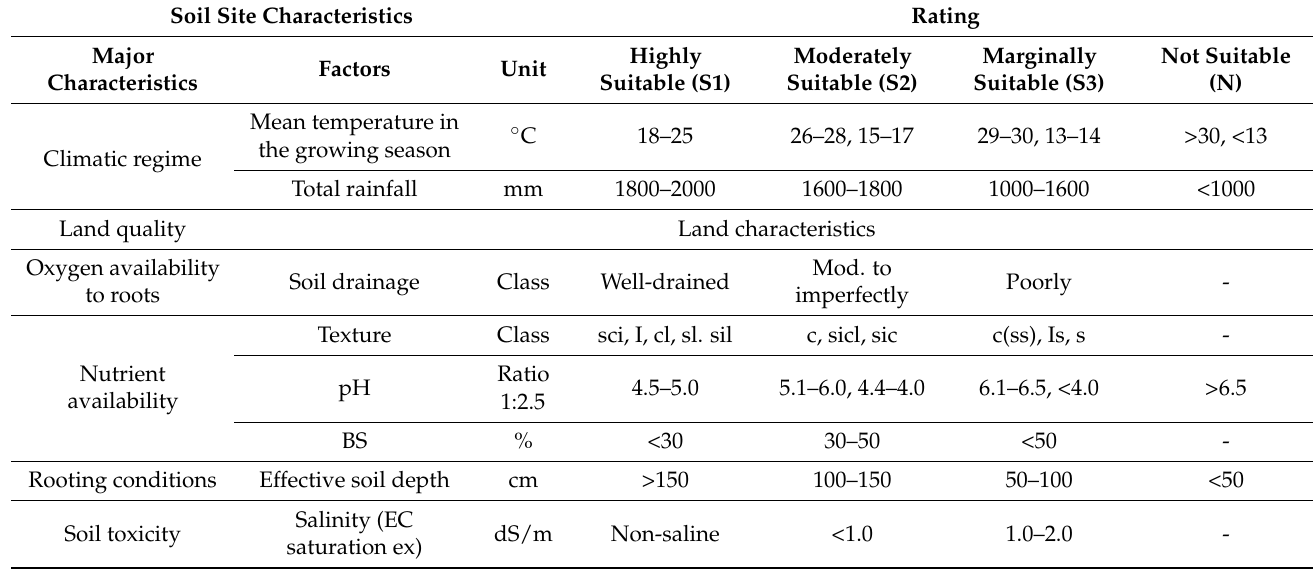
Figure 2. Suitability thematic layers for tea plantations: ( a ) rainfall, ( b ) temperature, ( c ) relief, ( d ) slope, ( e ) texture, ( f ) soil pH, ( g ) soil depth, ( h ) base saturation, ( i ) soil EC, ( j ) soil drainage, ( k ) land use, ( l ) NDVI. Table 2. Soil site suitability criteria (crop requirements) for tea